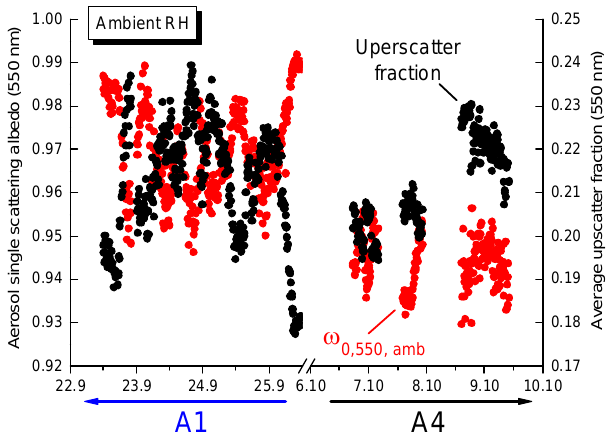
Fig. 14. Time series of the calculated aerosol single scat- tering albedo ( ω 0 , 550nm , amb ) and estimated upscatter fraction ( β 550nm , amb ) at ambient RH for both marine (A1) and continen- tally polluted (A4)